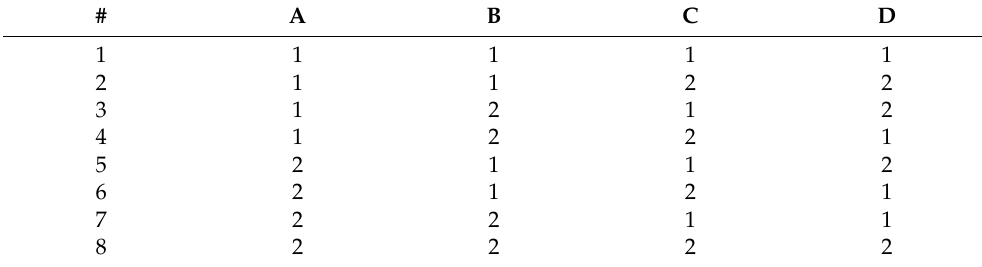
Table 3. Design of Experiments